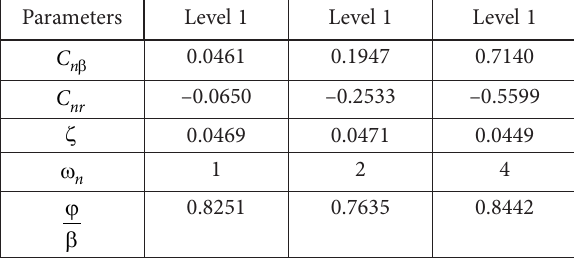
Figure 6. Simulation of a desired Dutch roll